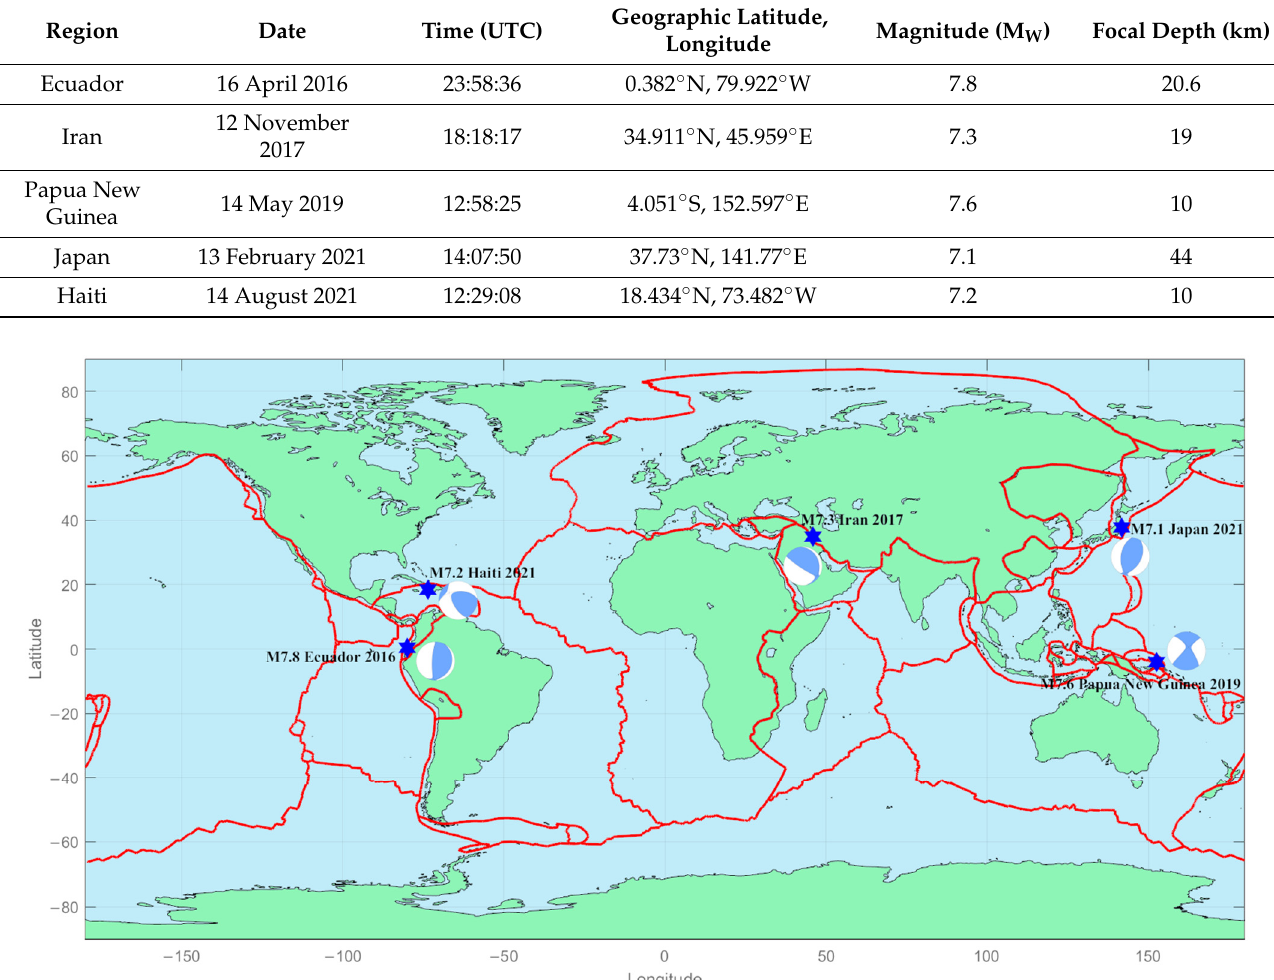
Figure 1. Map of the investigated earthquakes with overplot of main plate boundaries (red lines).